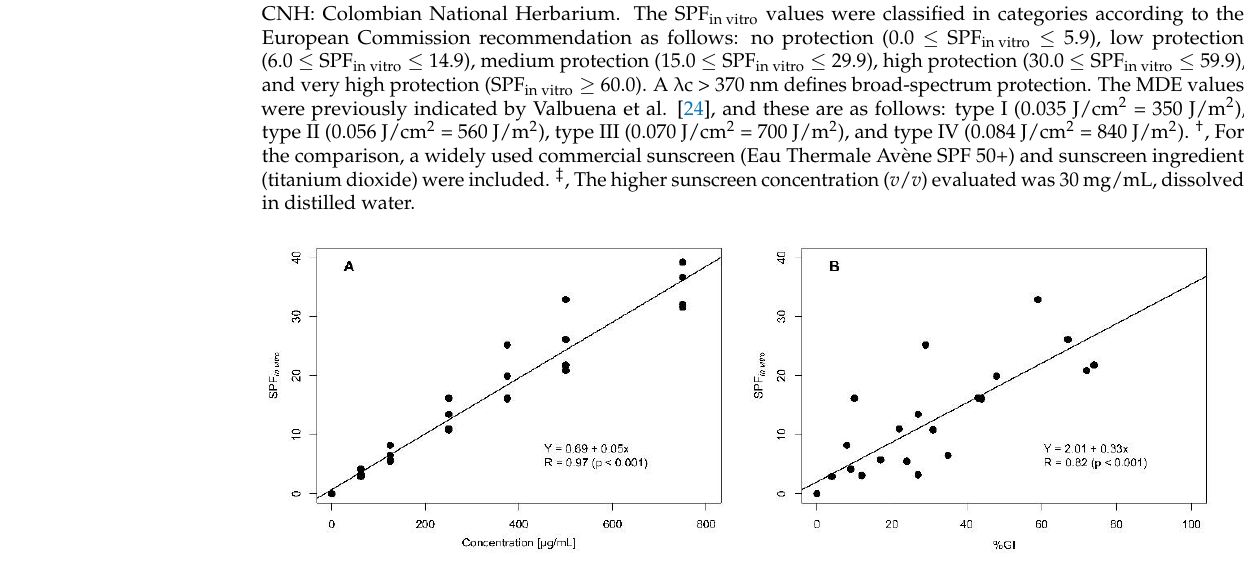
Figure 2. Correlation between UVB photoprotection efficacy (SPF in vitro ) and extract concentration ( A ) and %GI estimates ( B ). A database containing 28 paired SPF in vitro and %GI values, corresponding to photoprotective flower extracts, was used.